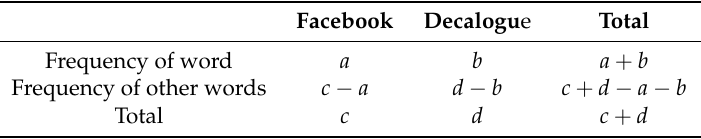
Table 1. Contingency table used to calculate the log-likelihood (LL)